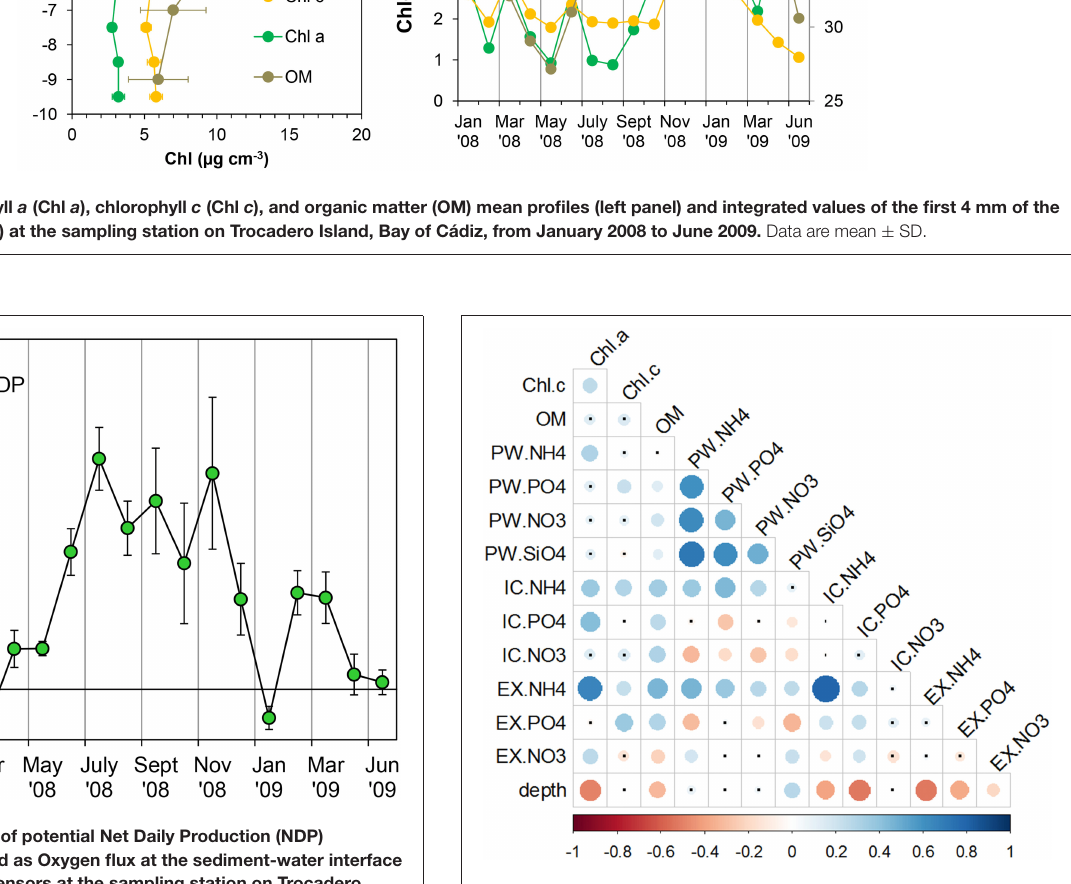
FIGURE 8 | Correlation matrix of chlorophylls and nutrient pools. Data used for correlations were the full data set of triplicate monthly profiles. Color bar represents the Spearman correlation coefficient with blue indicating a positive and red a negative relationship. Size and tone of the dots is directly related to the magnitude of correlation. Non-significant correlations are labeled with a small black